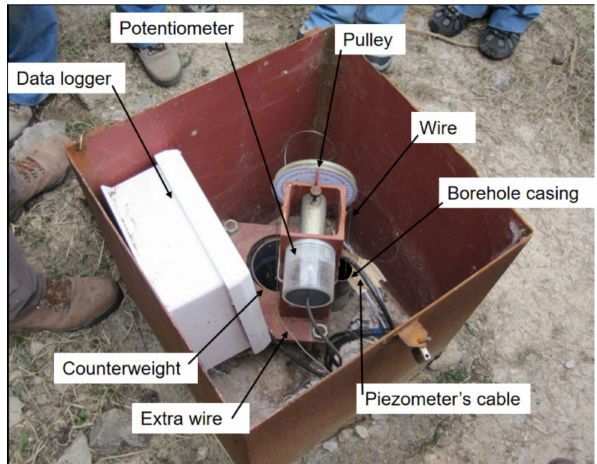
Figure 12. Head of one of the borehole wire extensometers installed at Vallcebre. The cable for the piezometer (black) can also be appreciated.